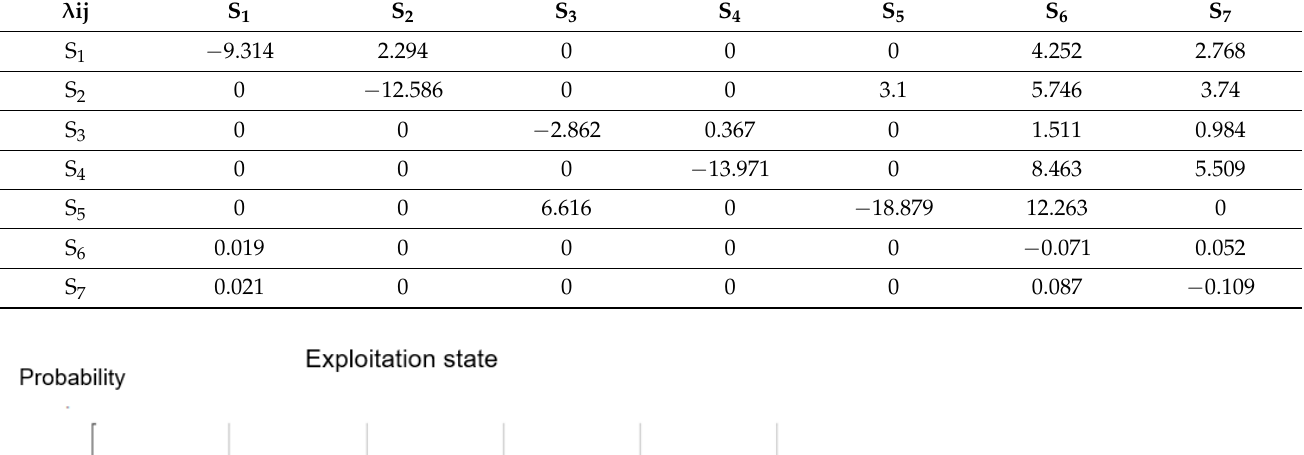
Table 4. Intensity of transitions between certain exploitation states, average values for the whole group of objects. The data below should be interpreted as follows: for instance the data 1.511 means a statistical amount of transitions per day between state S 3 and S 6 (own study).